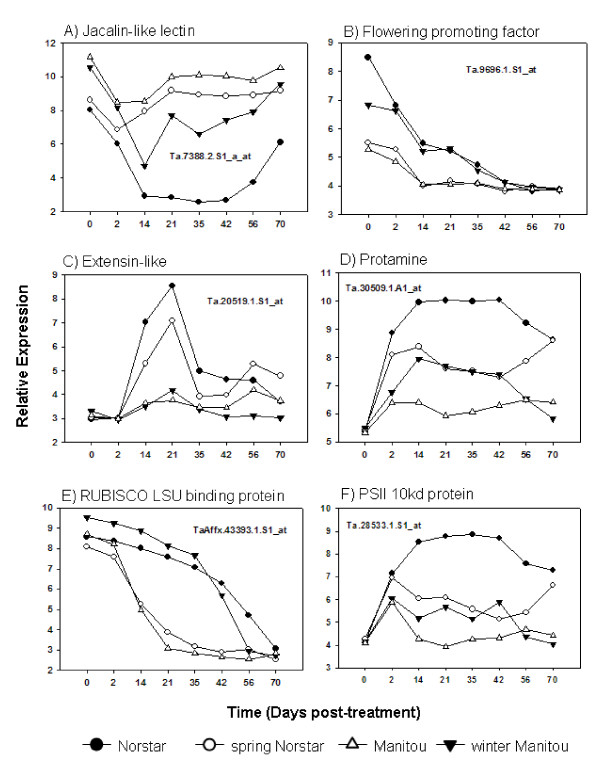
Expression profiles of selected most dynamically expressed genes in winter Norstar and spring Manitou and the near isogenic lines spring Norstar and winter Manitou acclimated at 6°C for 0 to 70 days.